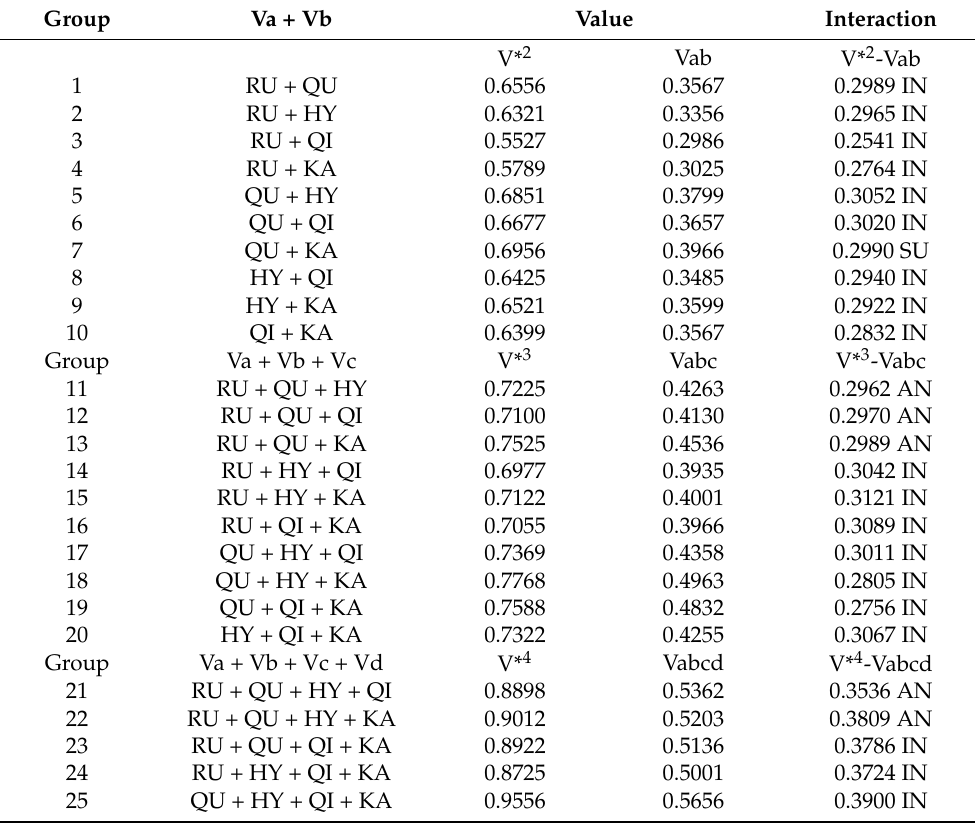
Table 3. Interaction effects of polyphenols in FSI extract on the α -glucosidase inhibition